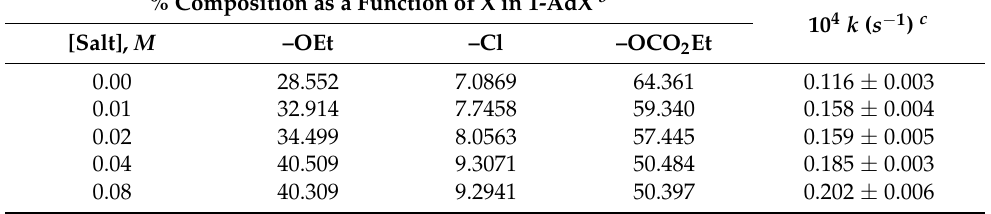
constants from duplicate runs, with associated standard